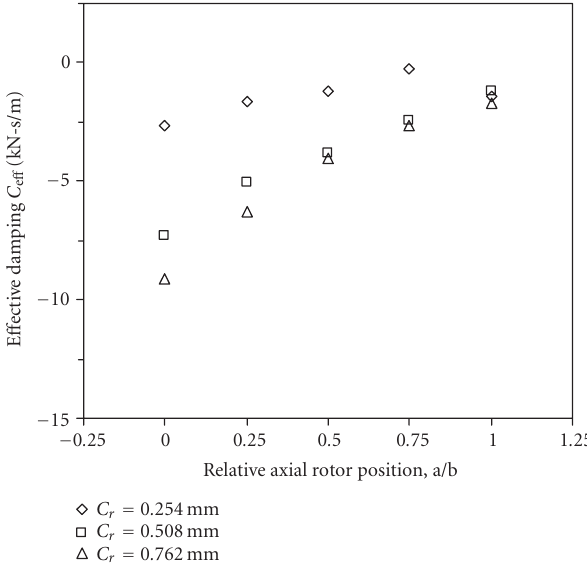
Figure 7: Predicted e ff ective damping coe ffi cient versus relative ax- ial rotor position a/b for high-low